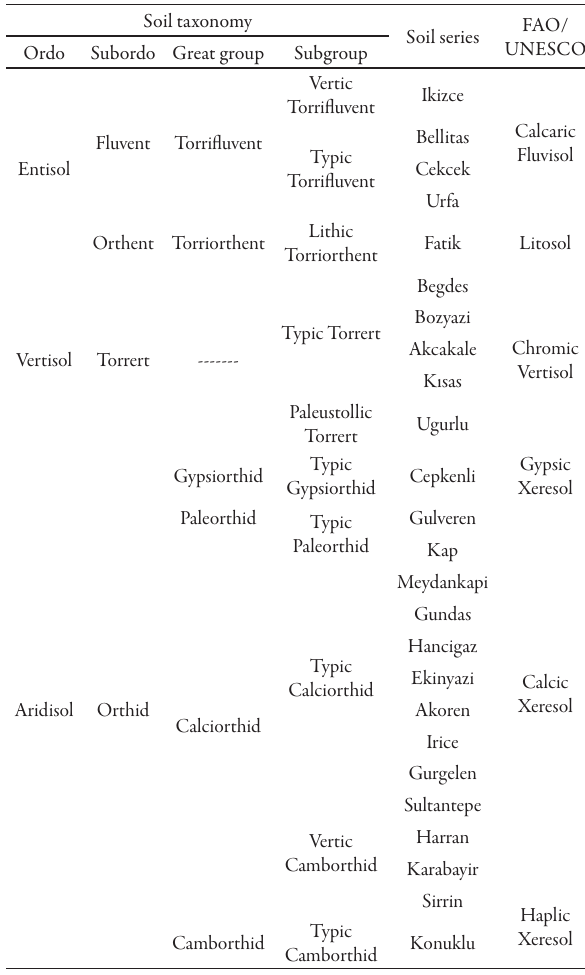
Tab. 1. Soil taxonomy of Harran Plain soils (SSS, 1975; FAO / UNESCO, 1974; Dinc et al. , 1988)